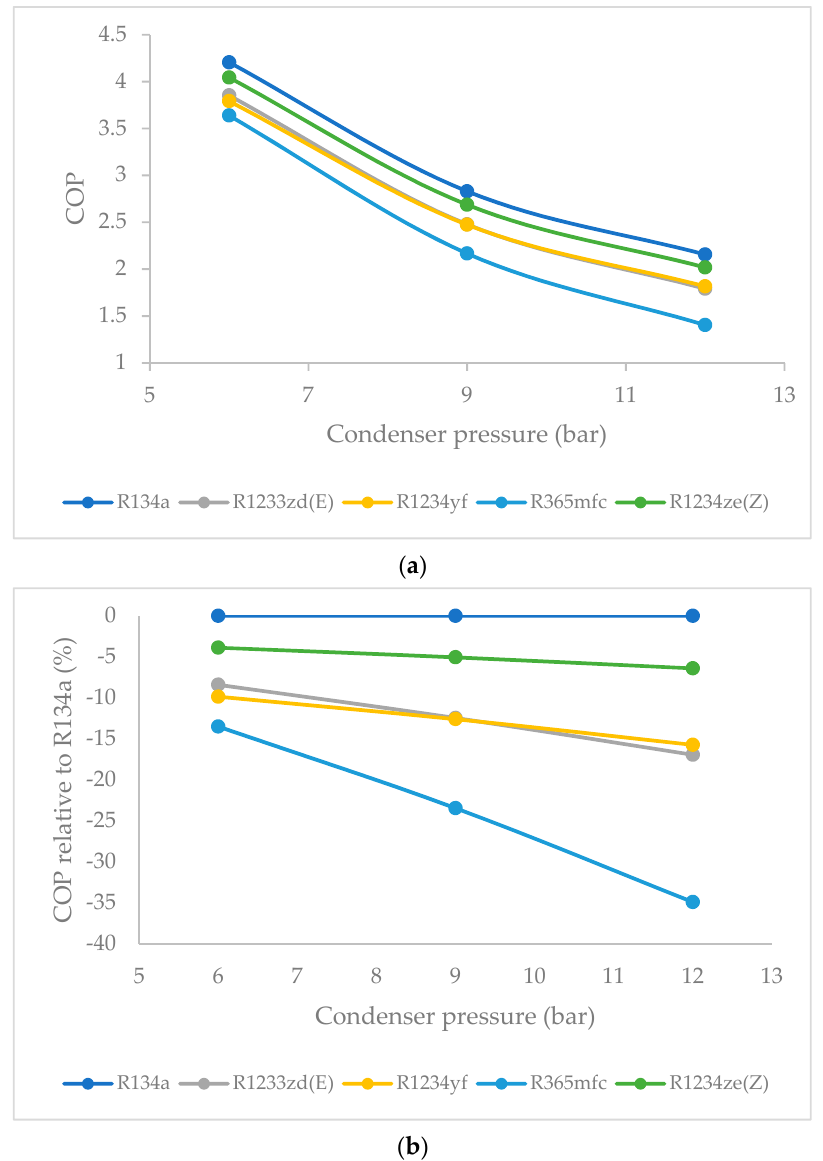
Figure 10. ( a ) Coefficient of performance (COP) as a function of condenser pressure (evaporator pressure = 1.5 bar). ( b ) COP relative to R134a (%) (evaporator pressure = 1.5 bar).